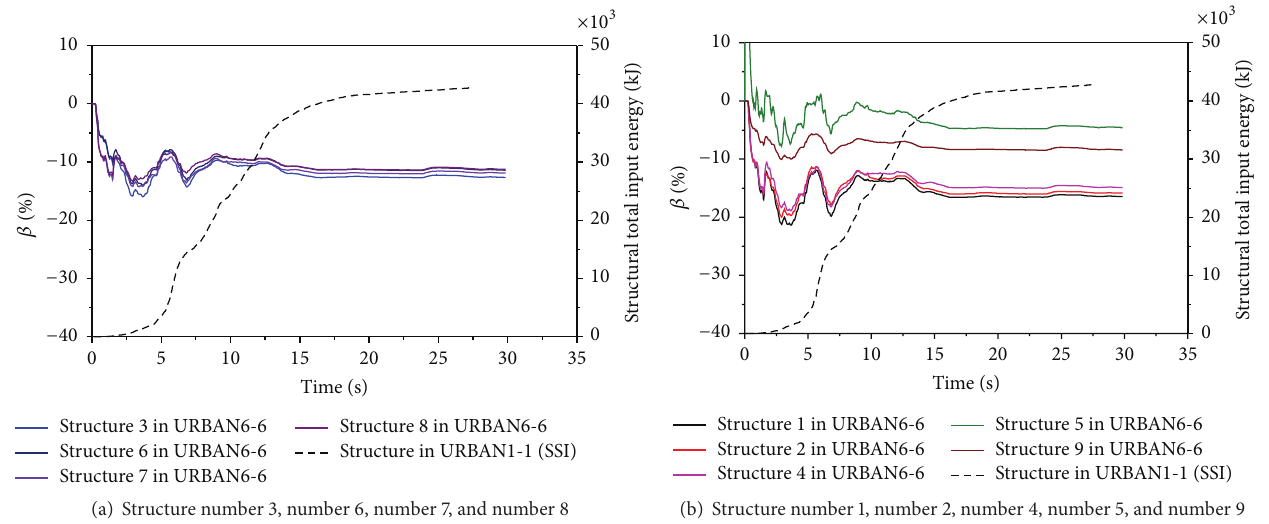
Figure 14: Interaction among structures in terms of influence coefficient 𝛽 (URBAN6-6, 𝐷 = 0.5 , MCH000, 𝑆𝑋 ). The solid lines are the influence coefficient 𝛽 of structures in URBAN6-6. The dashed line is the structural total absorbed energy in the URBAN1-1 (SSI) case.